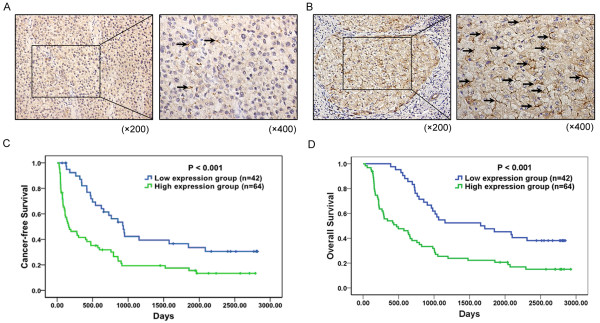
Immunohistochemistry of TLR4 expression in HCC tissues and its prognostic implication. (A) and (B) The membranous expression of TLR4 was seen to be low in 42/106 of HCC tissues (A), and high in 64/106 (B). Original magnification left × 200, right × 400. (C) Estimated cancer-free survival according to the expression of TLR4 in 106 cases of HCCs (the Kaplan-Meier method). Log-rank test shows that HCC patients in the high TLR4 expression group have poorer cancer-free survival than those in the low TLR4 expression group (P < 0.001). (D) Overall survival was analyzed in the same cohort of HCC patients and the results showed that HCC patients in the high TLR4 expression group also have poorer overall survival than those in the low TLR4 expression group (P < 0.001). HCC, hepatocellular carcinoma; TLR4, toll-like receptor 4.